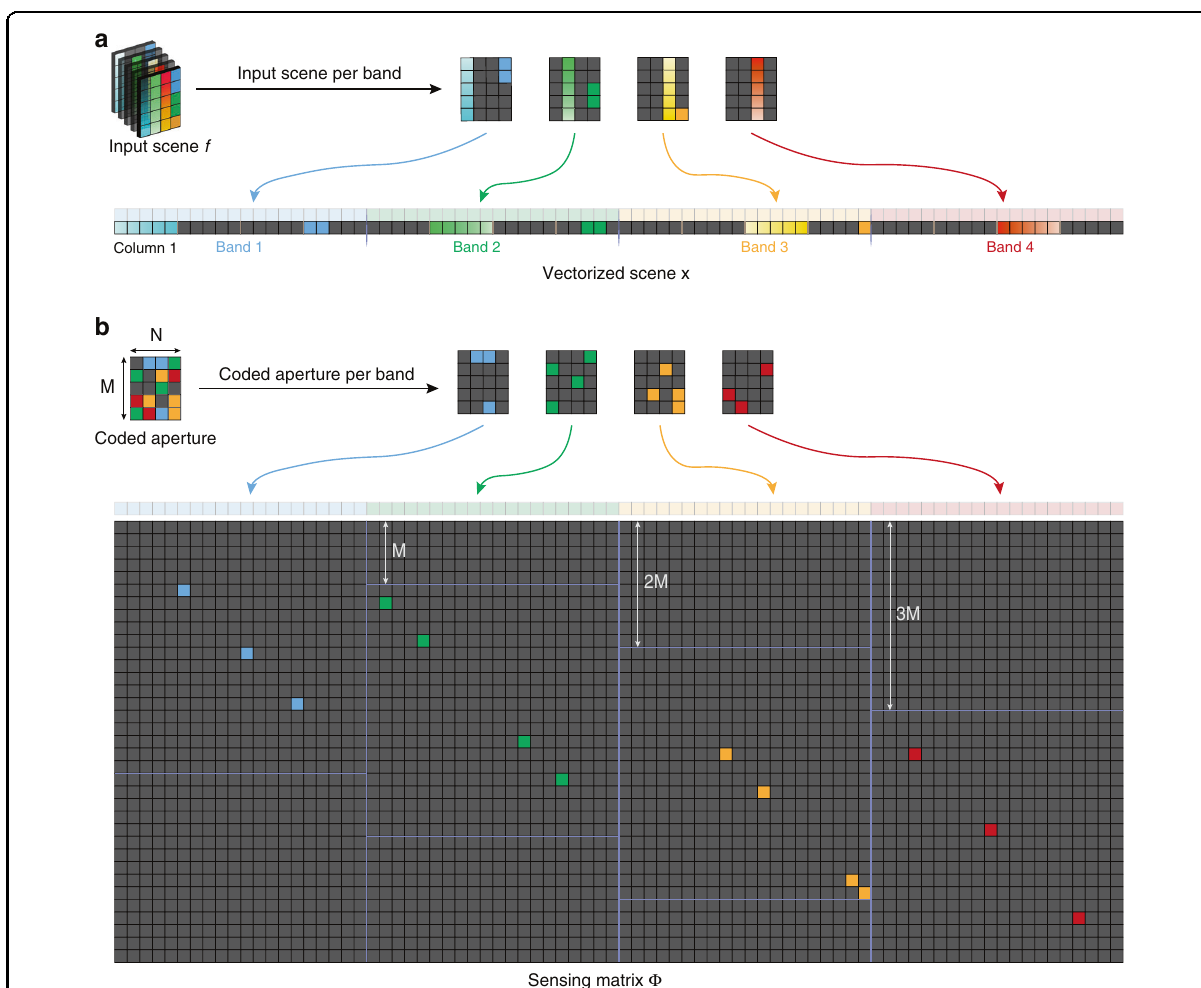
Fig. 4 Vectorization and coded-aperture-related sensing matrix generation procedure. a Illustration of the vectorization process. For a matrix A , vectorization means stacking the columns of A on top of one another; For a spectral cube of the input scene f ( m , n , l ), vectorization means stacking the vectorized 2D slice on top of one another. b Illustration of generating sensing matrix from colored coded aperture in SD-CASSI architecture. It consists of a set of diagonal patterns that repeat in the horizontal direction, each time with a unit downward shift M that accounts for dispersion. Each diagonal pattern is generated from the vectorized coded aperture pattern of a band. The block – unblock coded aperture is similar, just turning the color bands into black and